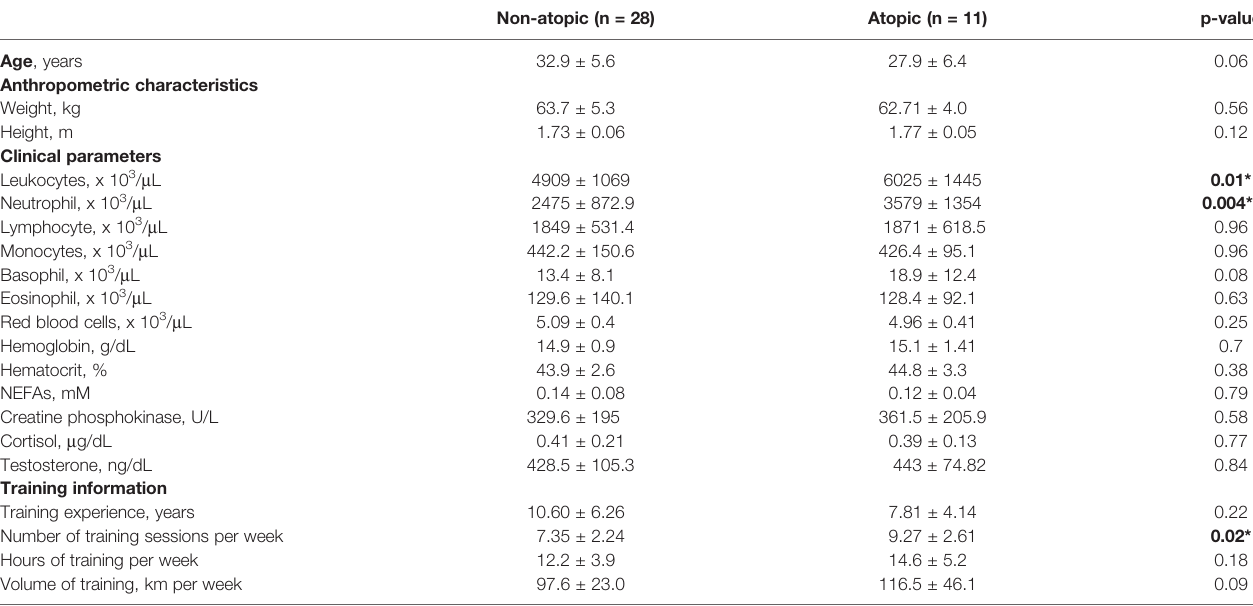
TABLE 2 | Age, anthropometric characteristics, clinical parameters and training information from non-atopic and atopic runners at